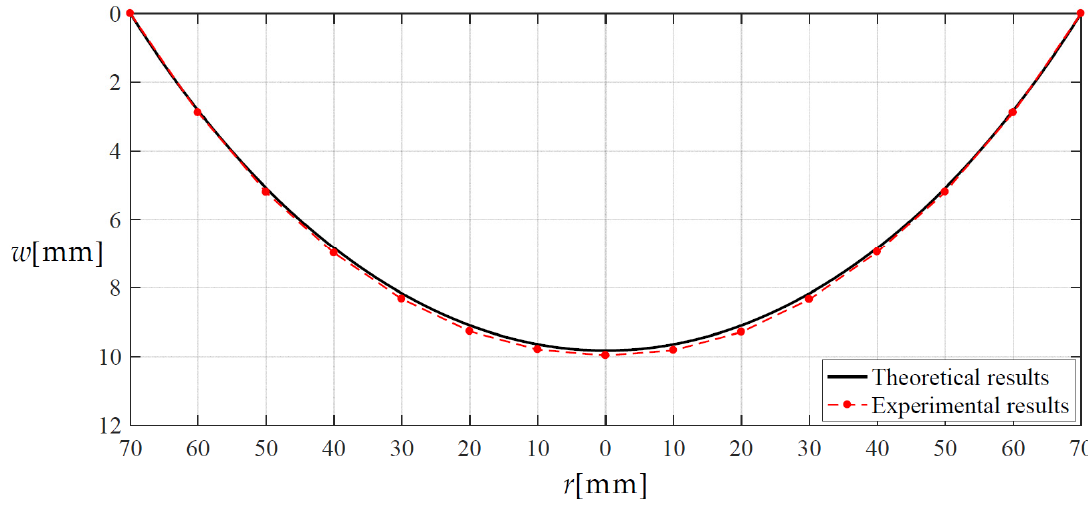
Figure 13. Membrane deflection along the diameter when H = 97.5